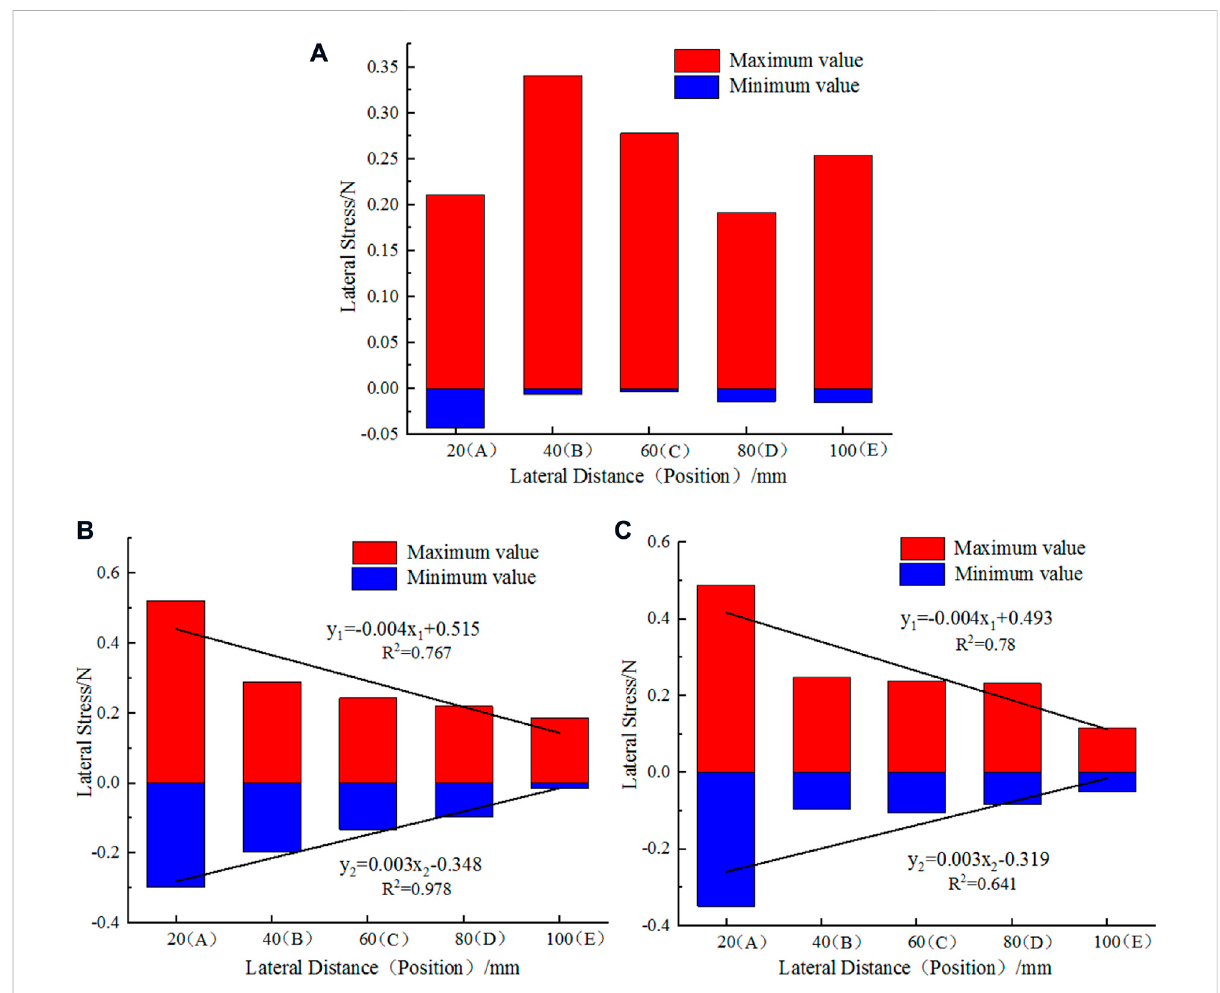
FIGURE 9 Extremal lateral stresses at different lateral distances and depths: (A) shallow soil layer; (B) middle soil layer; and (C) deep soil